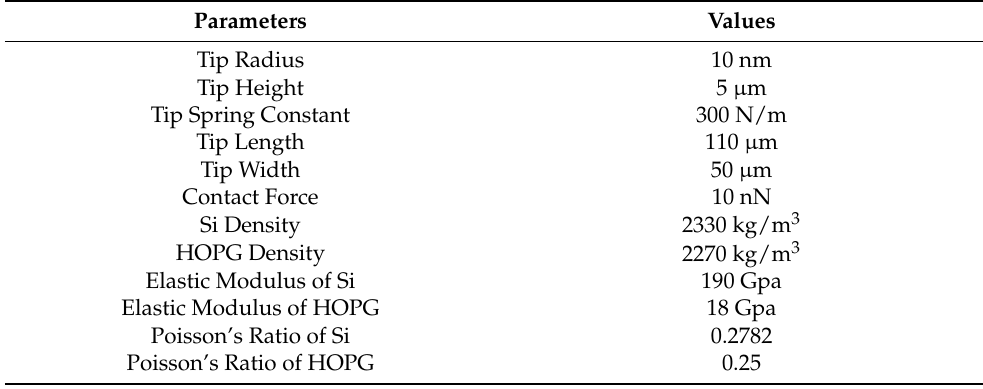
Table 2. Experimental parameters used in the simulation.